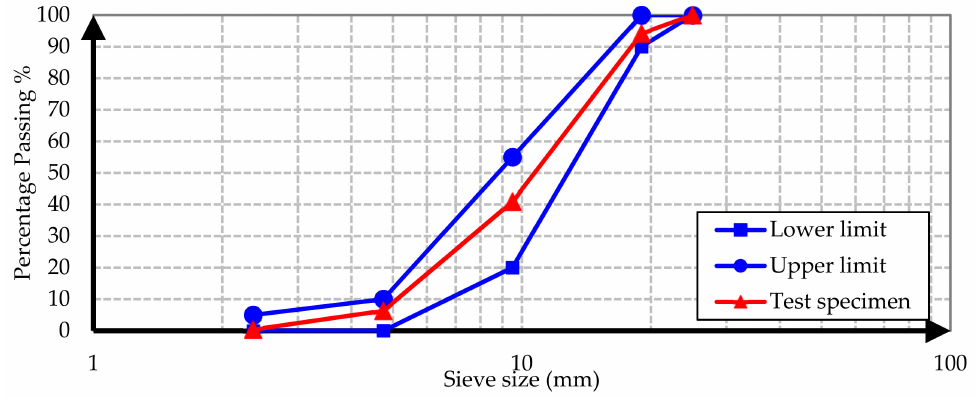
Figure 1. Conventional gravel sieve analysis grading curve.